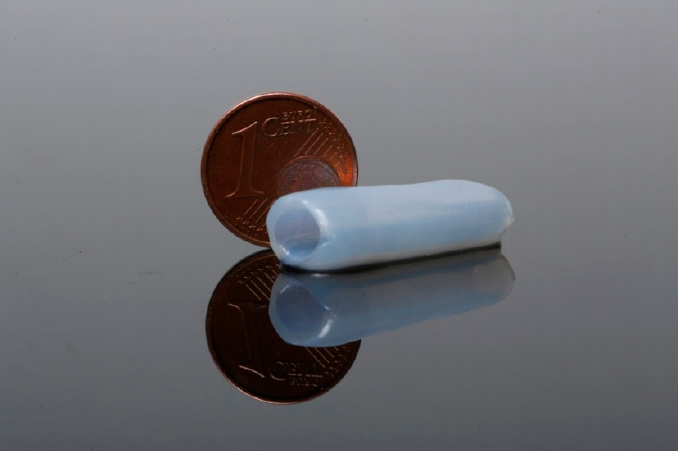
Figure 1. Photograph of a biocellulose tube (length: 50 mm, wall thickness: 1.5 mm), prepared according to variant 3 on a cylindrical bamboo template with a diameter of 5 mm. To visualize the size ratios of the biocellulose tube, it is placed next to a cent coin (© Andreas Heckel).